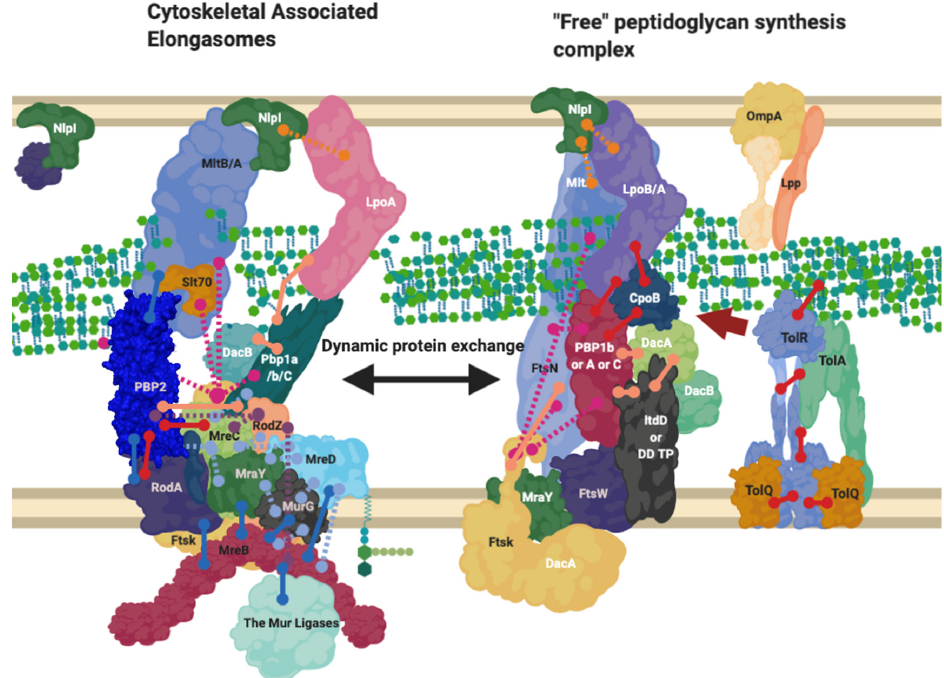
Figure 6. The Elongasome complex interactions. Interactions of the elongasome proteins. The elongasome is a series of complexes that are either attached to or not attached to the MreB filament. Localisation-dependent studies have shown the enzymes involved co-localise at the MreB filament [9,10], and each interaction is cited. This diagram is one of many possible configurations based on the current data, with the incorporation of the flippase not mentioned. Proteins are shared between complexes. Diagram rendered using BioRender. Connections: Purple [57], Red [9,23,31], Cyan [53], Orange [54], Pink [58], Peach [9,29,47,50,59,60], Blue [10,32,61–63].